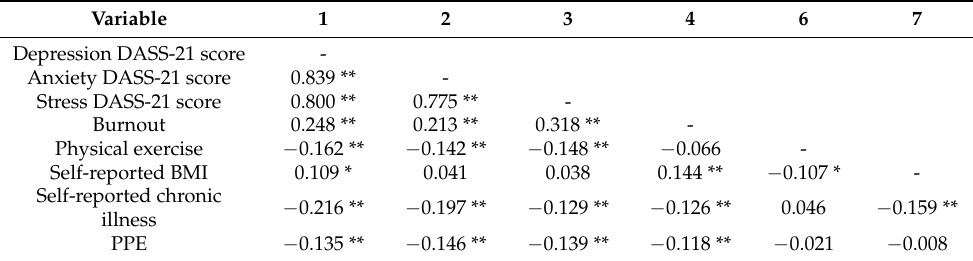
Table 4. Correlation matrix for self-reported stress, anxiety, and depression scores and their predictors. Variable